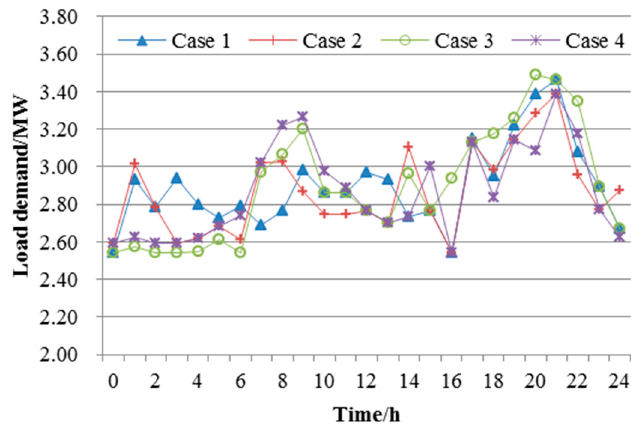
Figure 15. Net power load demand curve in various cases.